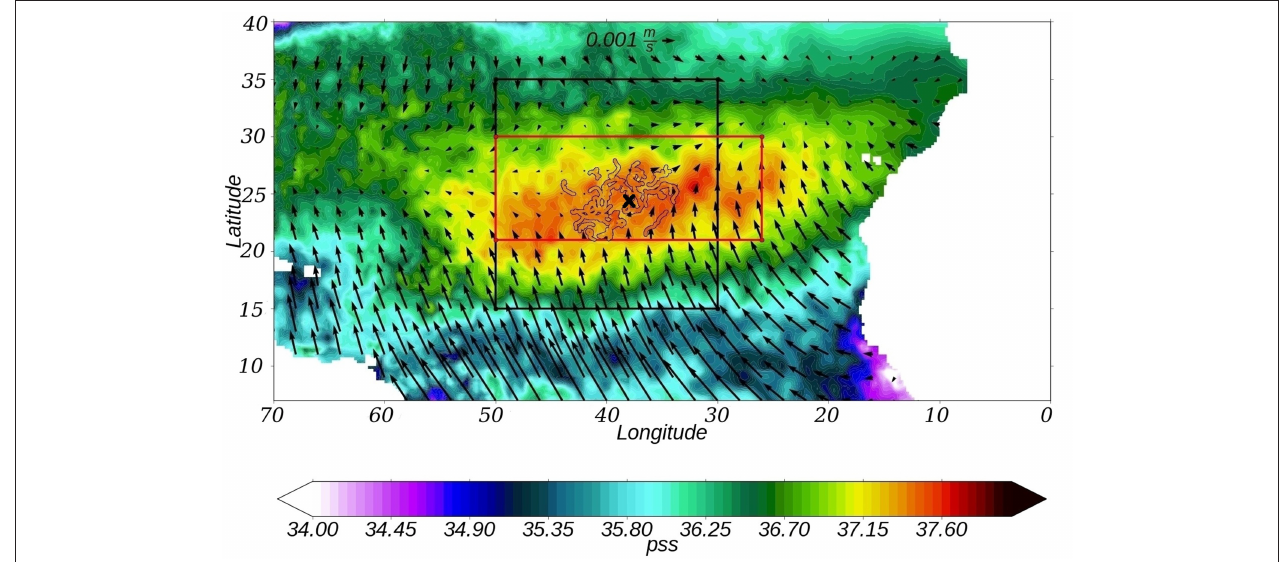
FIGURE 1 | North Atlantic subtropical region, January 2013. Climatological monthly mean SSS from SMOS and Ekman velocity field using ERA-Interim. The black box indicates SPURS region. The red box is the region that was chosen for estimation of salinity budget. Black cross is the mooring position at 24.5 ◦ N 38 ◦